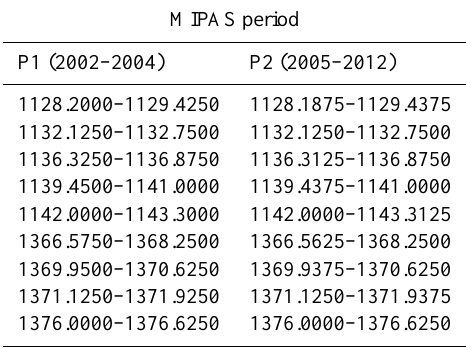
Table 1. Spectral windows for MIPAS SO 2 retrieval [cm − 1 ]. Table 2. Results of retrieval simulations for enhanced profiles. The